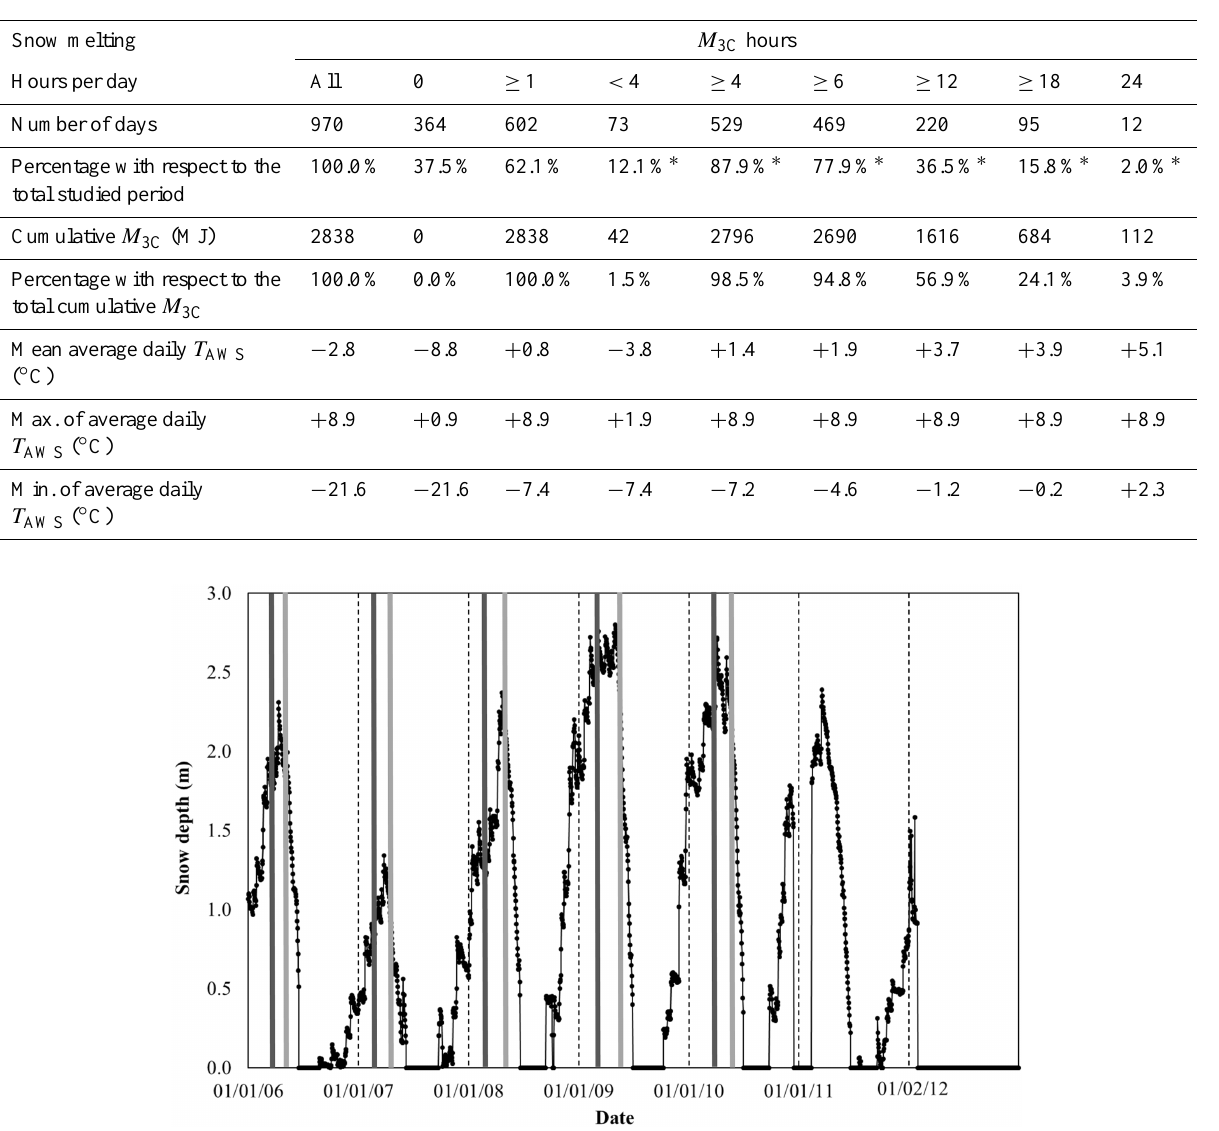
Figure 3. Snow depth data measured by the sonic ranger (Campbell SR50) installed on the mast of the AWS1 Forni. The beginning of the snow melting process is shown with a dark-grey line and the beginning of the actual snow ablation with a light-grey